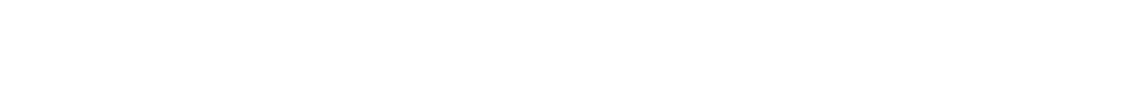
Frontiers in Microbiology | Microbial Physiology and